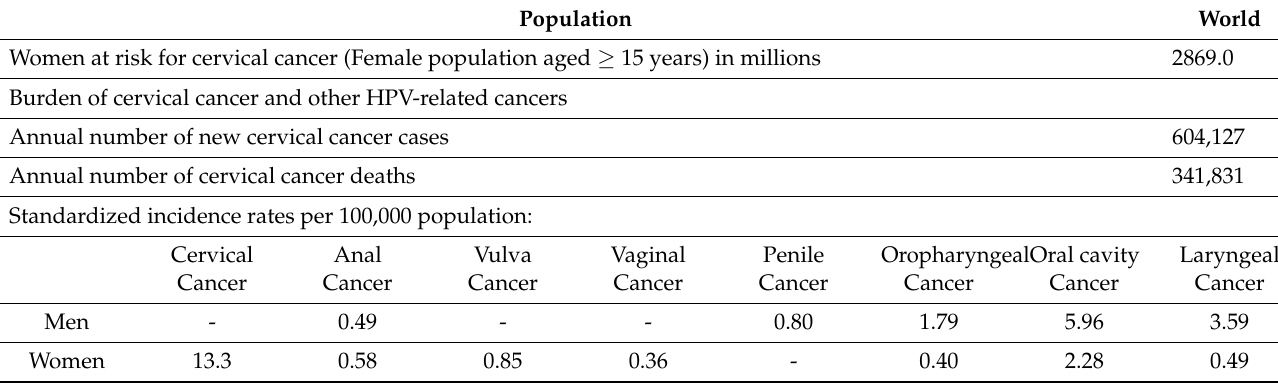
Table 1. Key statistics of HPV-related cancers in the world. Population World